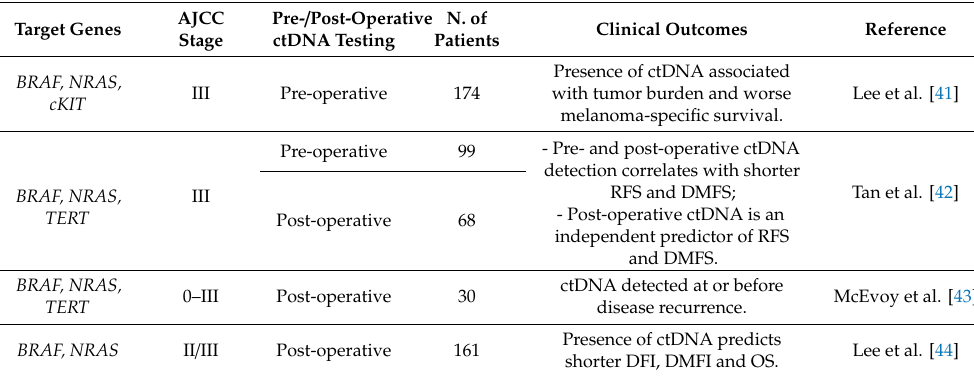
Table 1. Main studies that addressed the prognostic value of ctDNA testing in patients with early (surgically resectable)